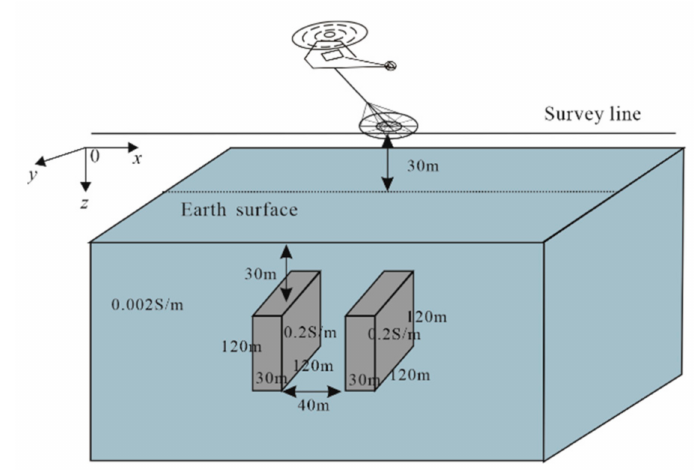
Figure 9. Two vertical dykes embedded in a homogeneous half-space.